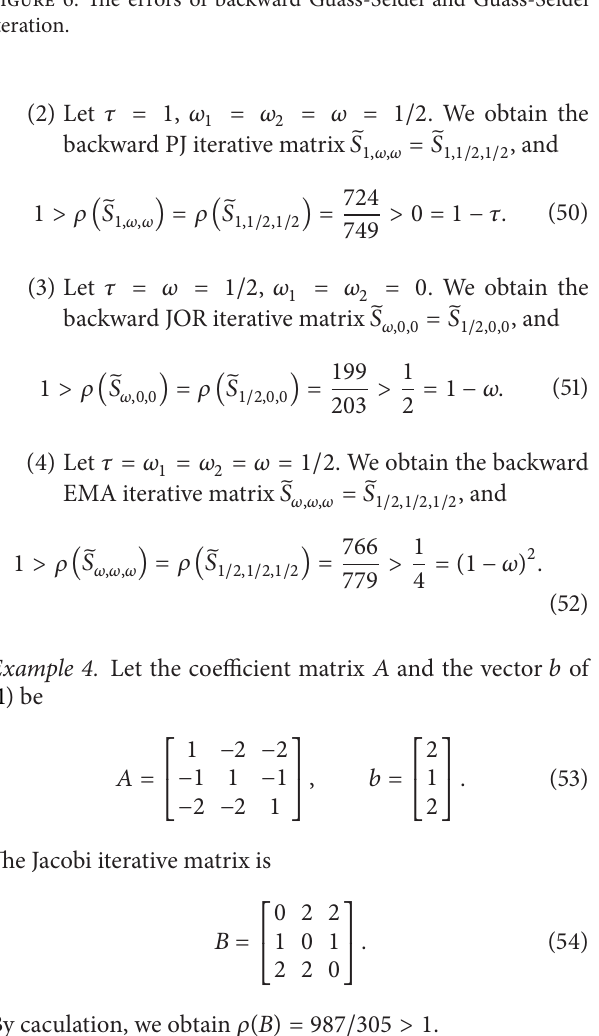
Figure 4: The errors of JOR and Jacobi iteration.